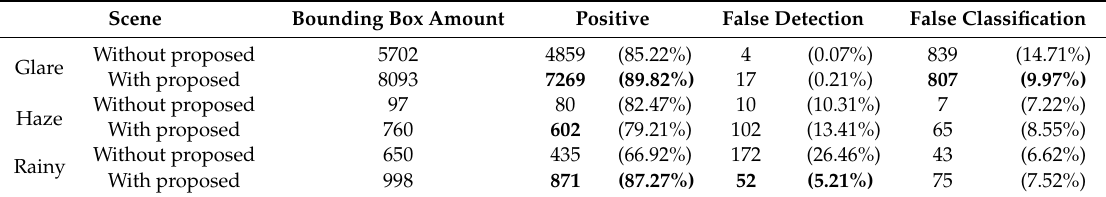
Table 3. Computation time of the system applied to different weather conditions. Weather Condition